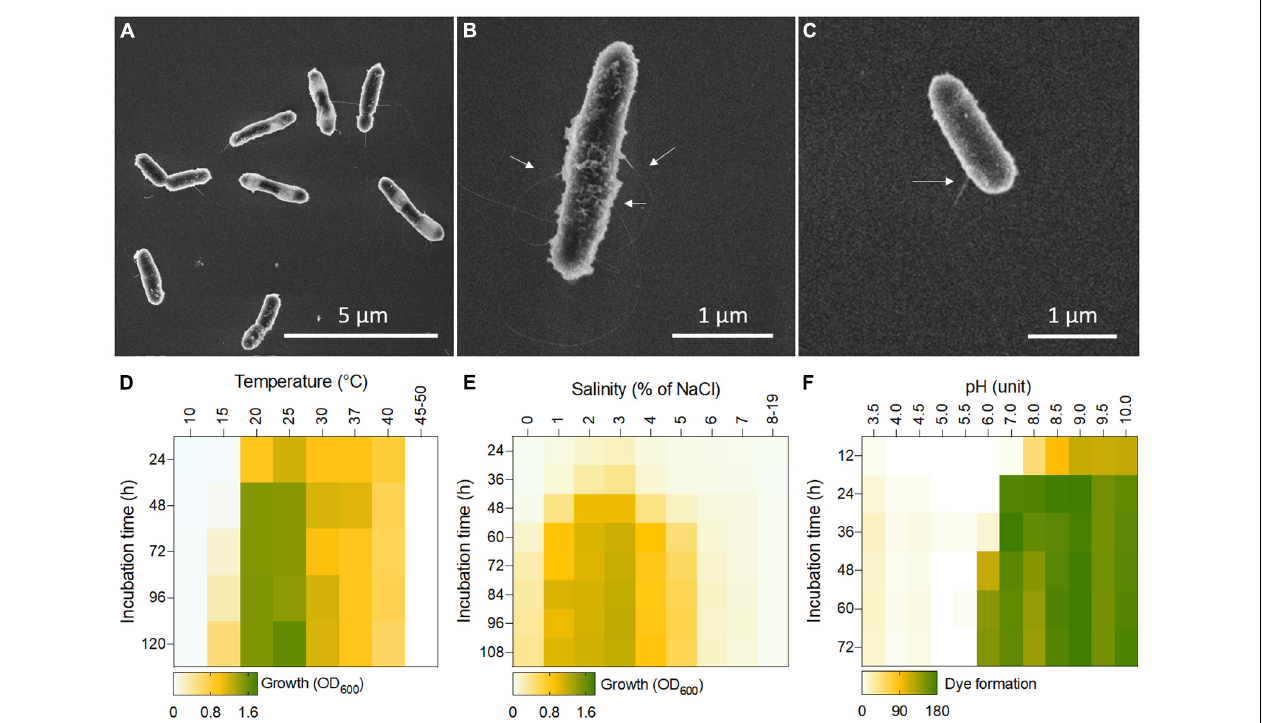
FIGURE 4 | (A) Scanning electron micrograph of R1DC41 T culture growth in MB at 26 ◦ C for 3 days depicts rod-shaped bacteria cells with pili; bar length, 5 µ m. (B,C) Individual cells from the suspension cultures of R1DC41 T show pili (white arrows); at least one pilum per cell is detected. Flagellar structures were not detected. Bar length, 1 µ m. (D–F) Heat maps showing the growth of R1DC41 T at different (D) temperatures and (E) salinity (% of NaCl) indicated as mean values of OD 600 ; (F) metabolic activity of R1DC41 T under different pH are reported as mean values of blue/purple color formation due to tetrazolium dye